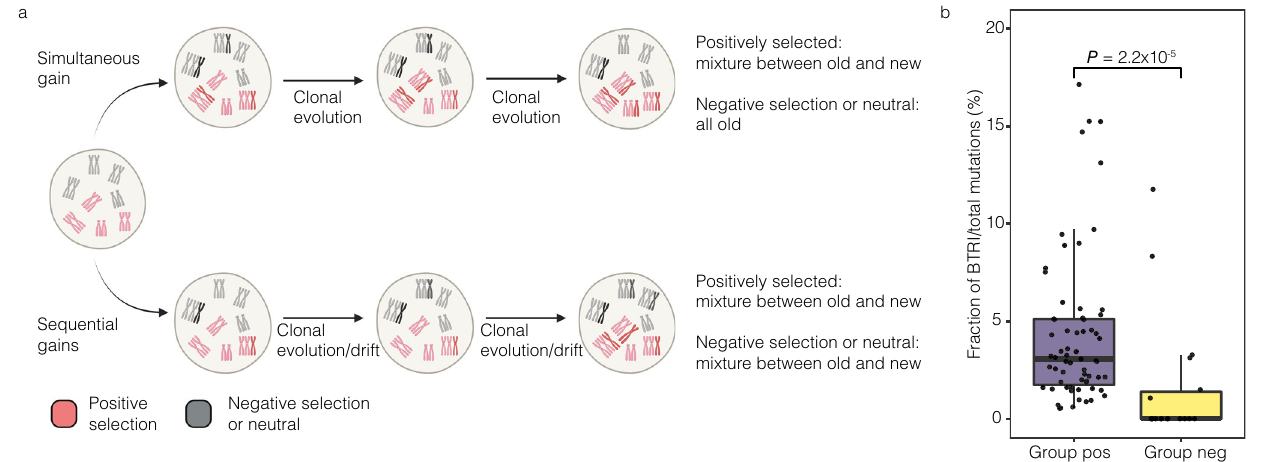
Fig. 4 | Analysis of somatic single nucleotide variants (SNVs) in trisomic chro- mosomes supports a simultaneous gain of most chromosomes followed by clonal evolution in high hyperdiploid (HeH) childhood acute lymphoblastic leukaemia (ALL). a Schematics of chromosomal gains in a scenario where chro- mosomes are either gained predominately by a fi rst hit or via sequential non- disjunction. Trisomies subjected to positive selection (strong-pos and weak-pos trisomies)areshowninredandtrisomiessubjectedtonegativeselectionorneutral (neg trisomies) in grey. These two scenarios are expected to result in different mixtures of older and newer chromosomes. b Boxplots of the fraction of BTRI